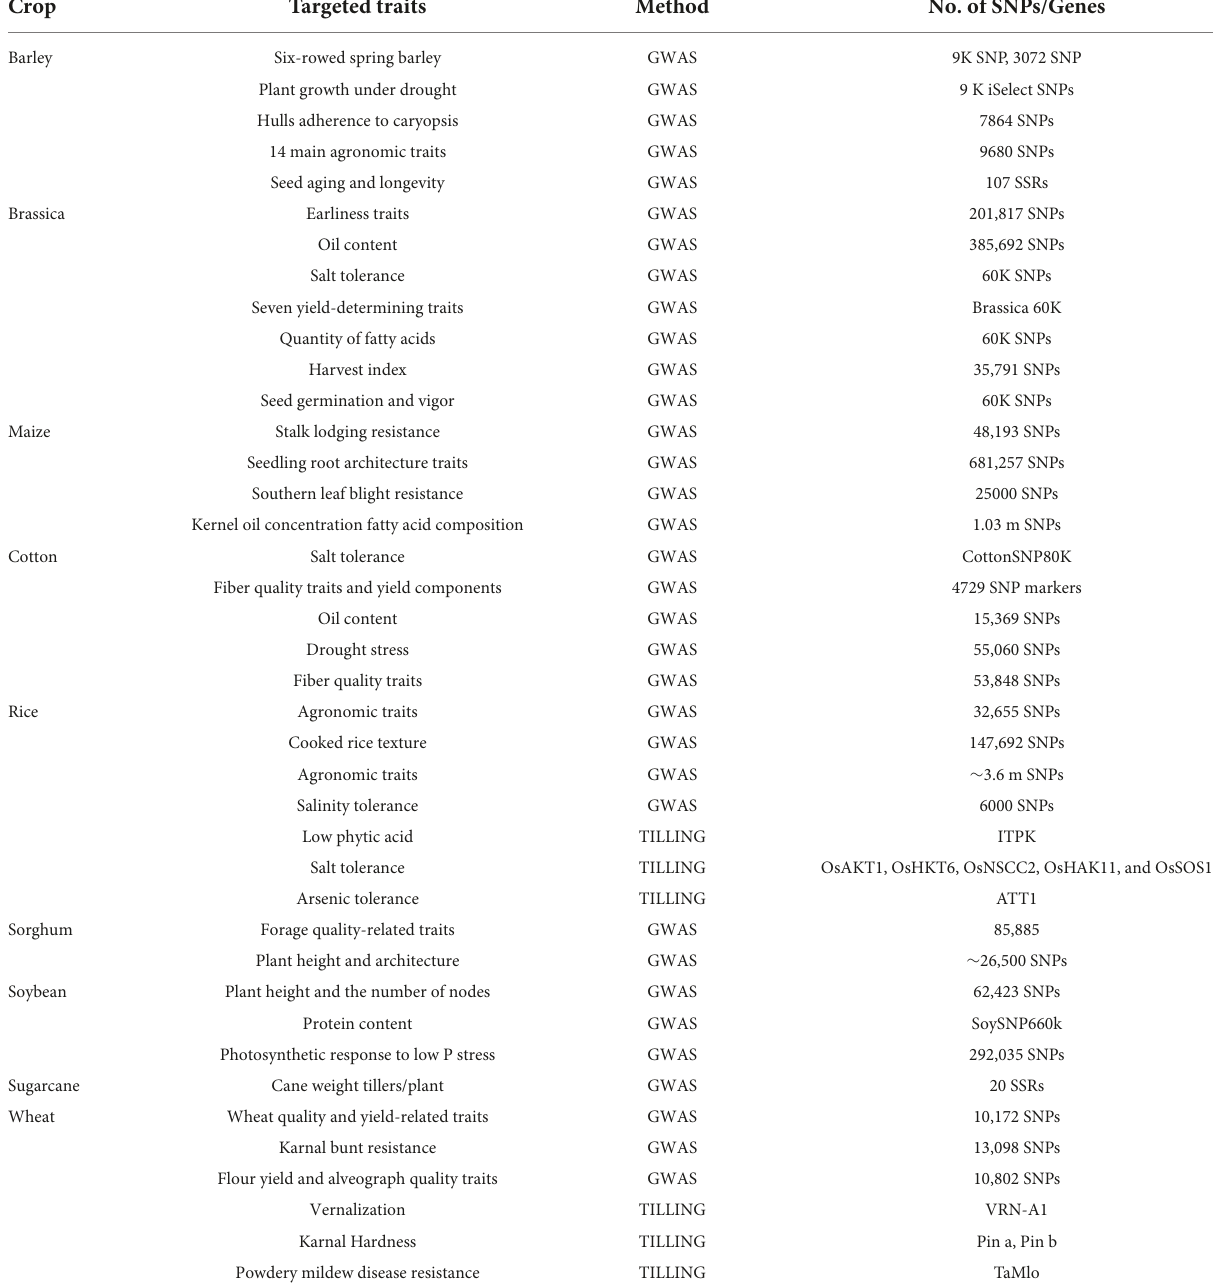
TABLE 2 SNP and marker gene identification in crop plants by utilizing NGS (Khalid et al., 2021; Khan et al., 2021).